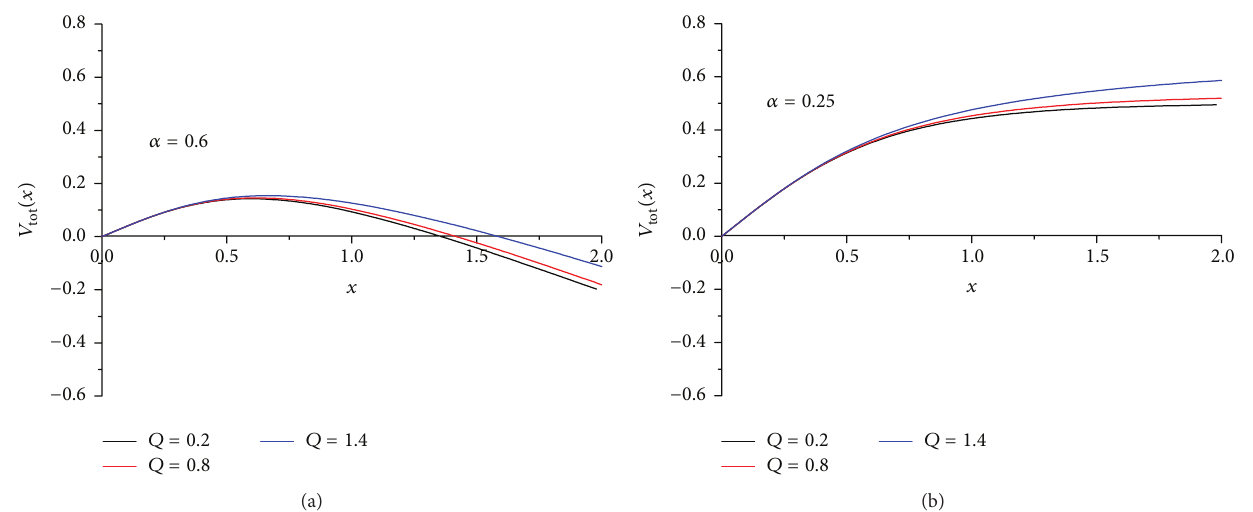
Figure 2: The total potential versus distance 𝑥 with fixed 𝛼 and varied 𝑄 . (a) 𝛼 = 0.6 ; (b) 𝛼 = 0.25 . In all of the plots from top to bottom 𝑄 = 0.2, 0.8, 1.4 .